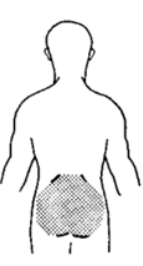
Figure 1. Region of low back pain. Adapted from (Kuorinka et al., 1987).